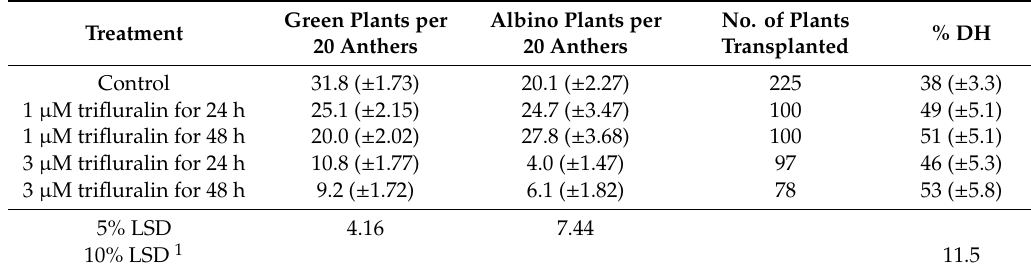
Table 4. Means ( ± SE) of green and albino plant numbers, expressed per 20 anthers, and chromosome doubling (% DH) following trifluralin treatment during anther culture on Tammarin Rock in